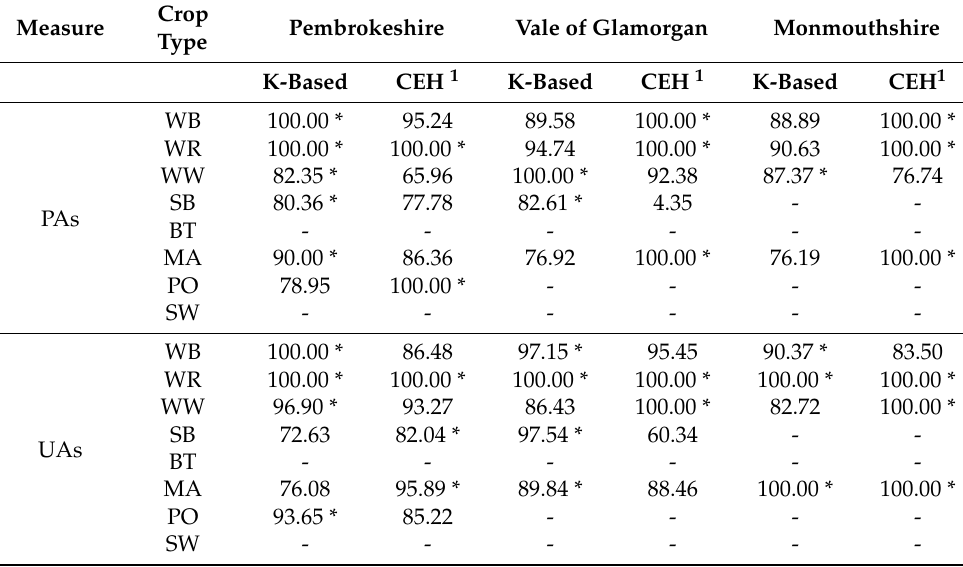
Table 4. Producer accuracies (PAs) and user accuracies (UAs) in% for the new (i.e., K-based) and CEH maps over Pembrokeshire, Vale of Glamorgan, and Monmouthshire.